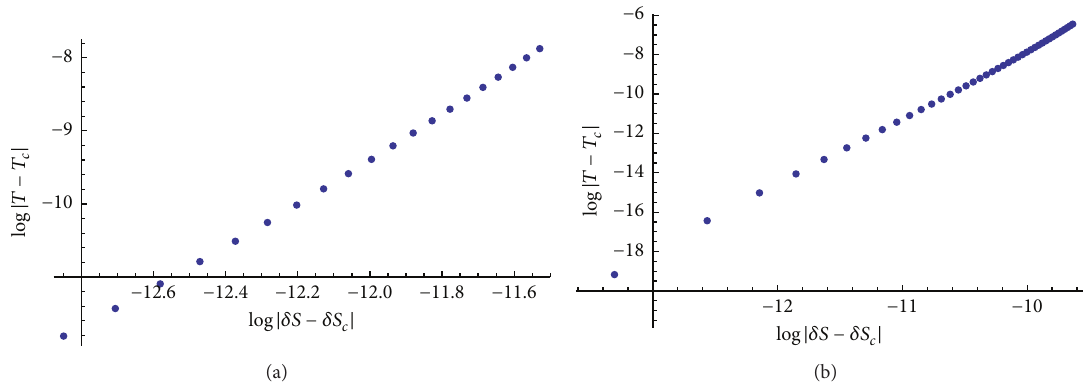
Figure 11: Relation between log |𝑇 − 𝑇 𝑐 | and log |𝛿𝑆 − 𝛿𝑆 𝑐 | near the critical point of second-order phase transition for different 𝜙 0 .